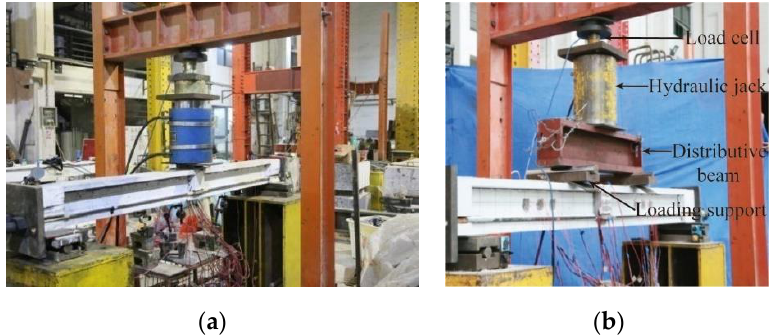
Figure 4. View of test setup: ( a ) three-point loading; ( b ) four-point loading.